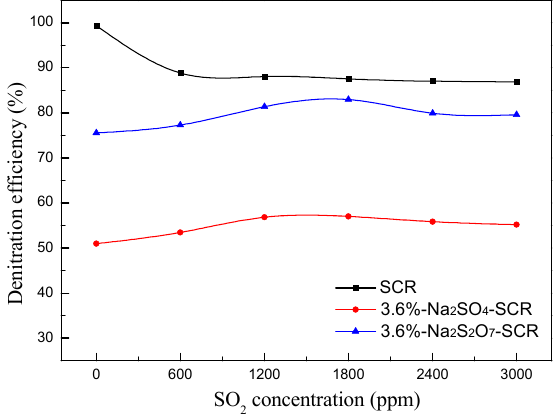
Figure 4. Effect of SO 2 concentration on NO conversion. Reaction conditions: 500 ppm NO, 500